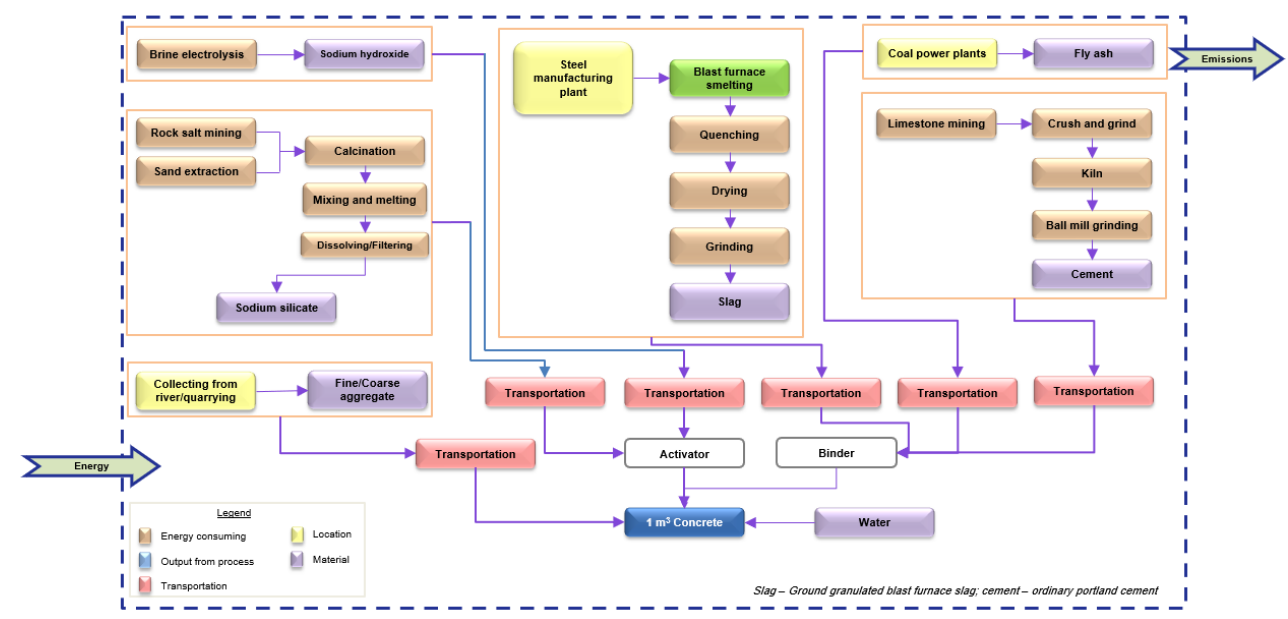
Figure 3. System boundary for AAC production.